Question: Name the type of graph shown.
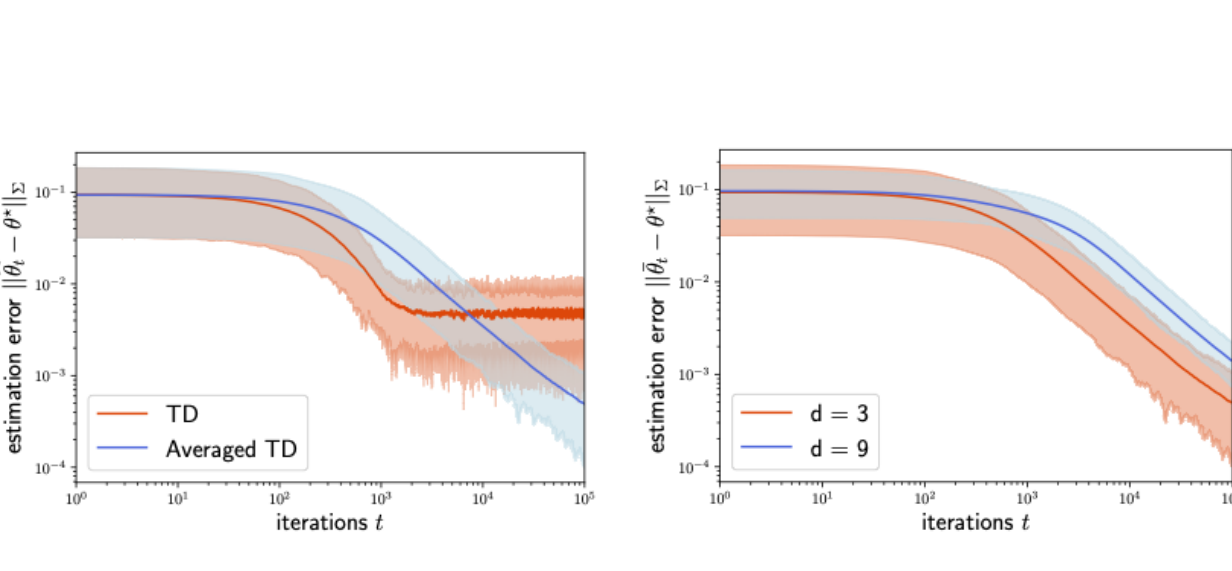
Answer: line